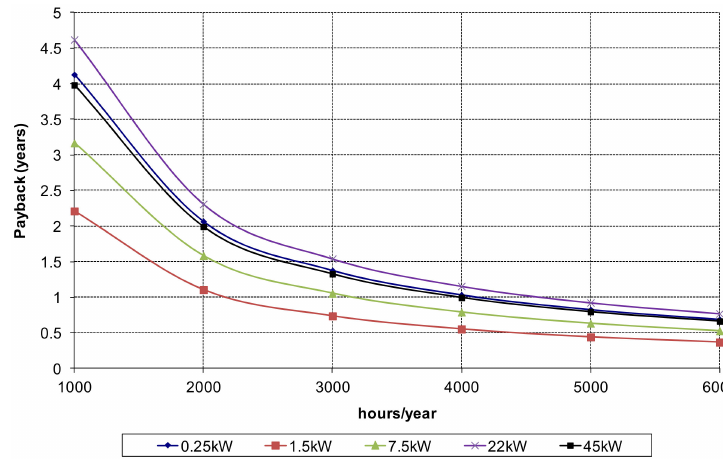
Figure 19. Payback versus of the hours/year in all the